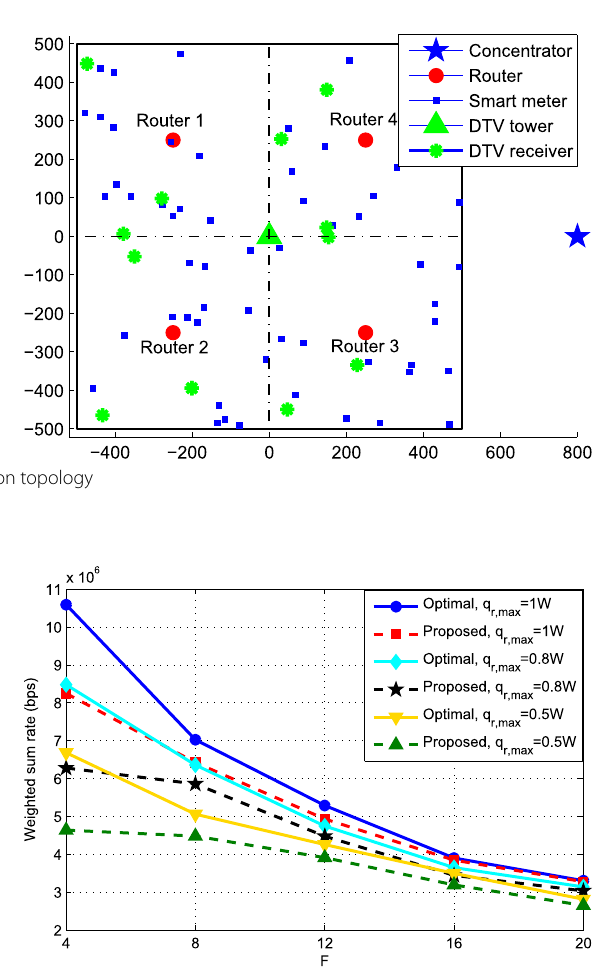
Fig. 4 Performance comparison of optimal and proposed algorithms for inner loop versus the number of